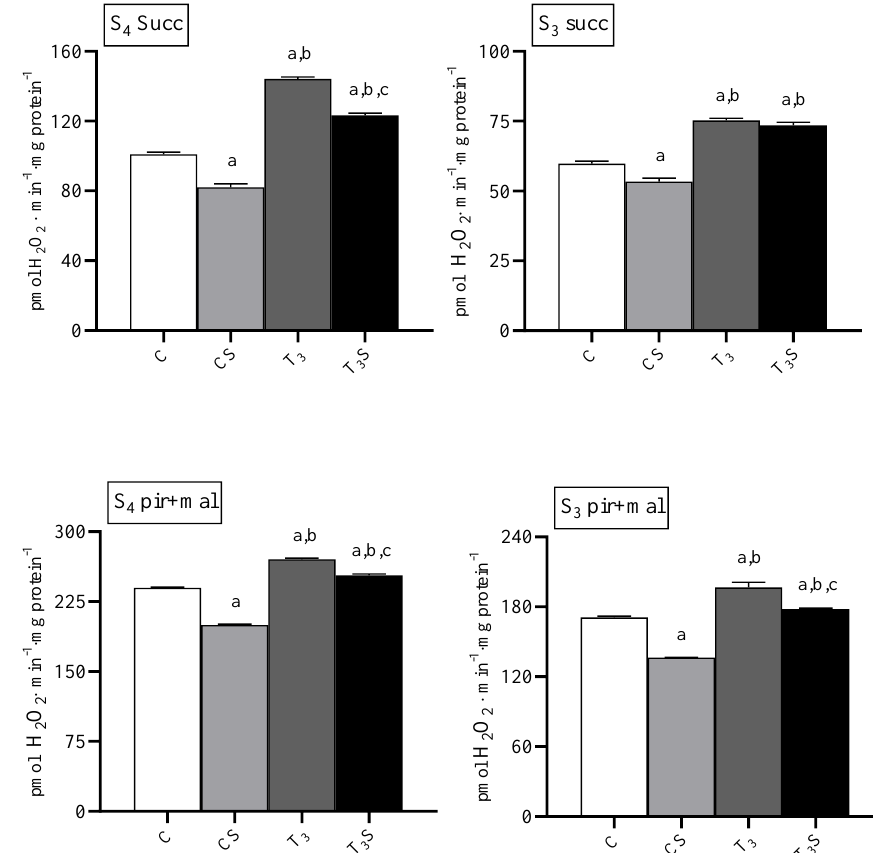
Figure 3. Rates of H 2 O 2 release in rat liver homogenates and mitochondria from: C, control rats; CS, control rats fed with Chlorella sorokiniana ; T 3 , rats made hyperthyroid by ip. T 3 administration; and T 3 S, hyperthyroid rats fed with Chlorella sorokiniana . Rates of H 2 O 2 release were measured in the absence (State 4, S 4 ) and in the presence (State 3, S 3 ) of ADP with Complex II (succinate, succ) and Complex I (pyruvate plus malate, pyr + mal)-linked substrates. The values are the means ± S.E.M of the data obtained on eight different livers. For each value, eight rats were used. a significant vs. C, b significant vs. CS, and c significant vs. T 3 . The level of significance was chosen as p < 0.05.